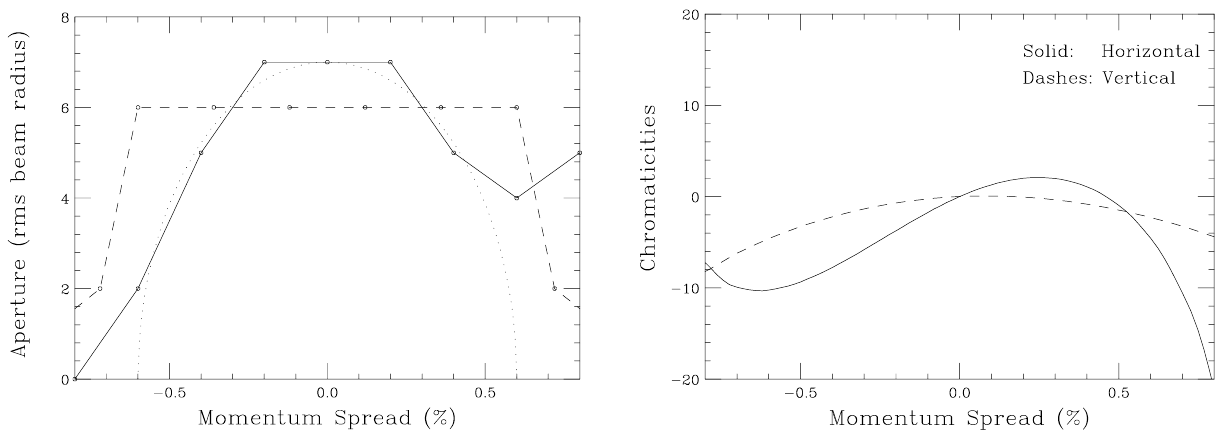
FIG. 50. Example (b): Left-hand-side plot is dynamical aperture of the lattice vs momentum offset. COSY calculation in solid line, 7 s rms in dot-dashed line, and TEAPOT calculation with modified FMC modules in dashed line. Right-hand-side plot is chromaticities vs momentum